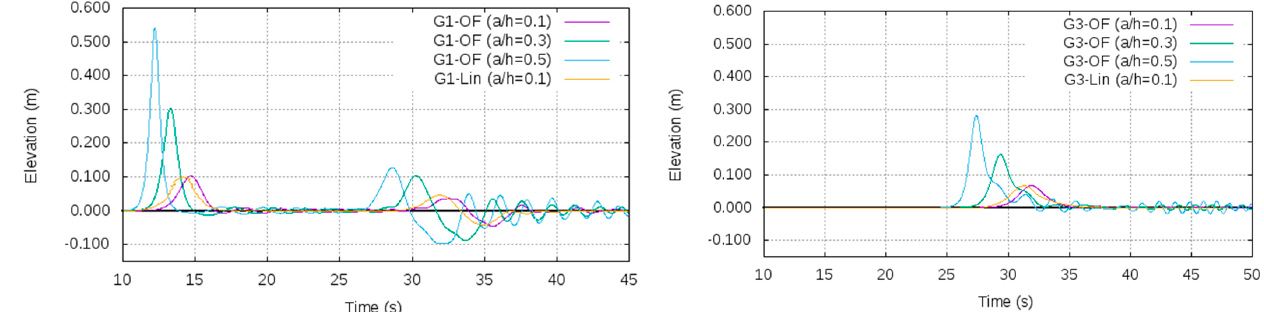
Figure 8. Relative comparison among the wave gauge results from the CFD simulations (Open- FOAM) for gauge G1 ( left ) and G3 ( right ) at 0.1, 0.3, and 0.5 a h = , and the results from [31] at for gauge G1 ( left ) and G3 ( right ) at a / h = 0.1, 0.3, and 0.5, and the results from [31] at a/h = a/h = 0.1.